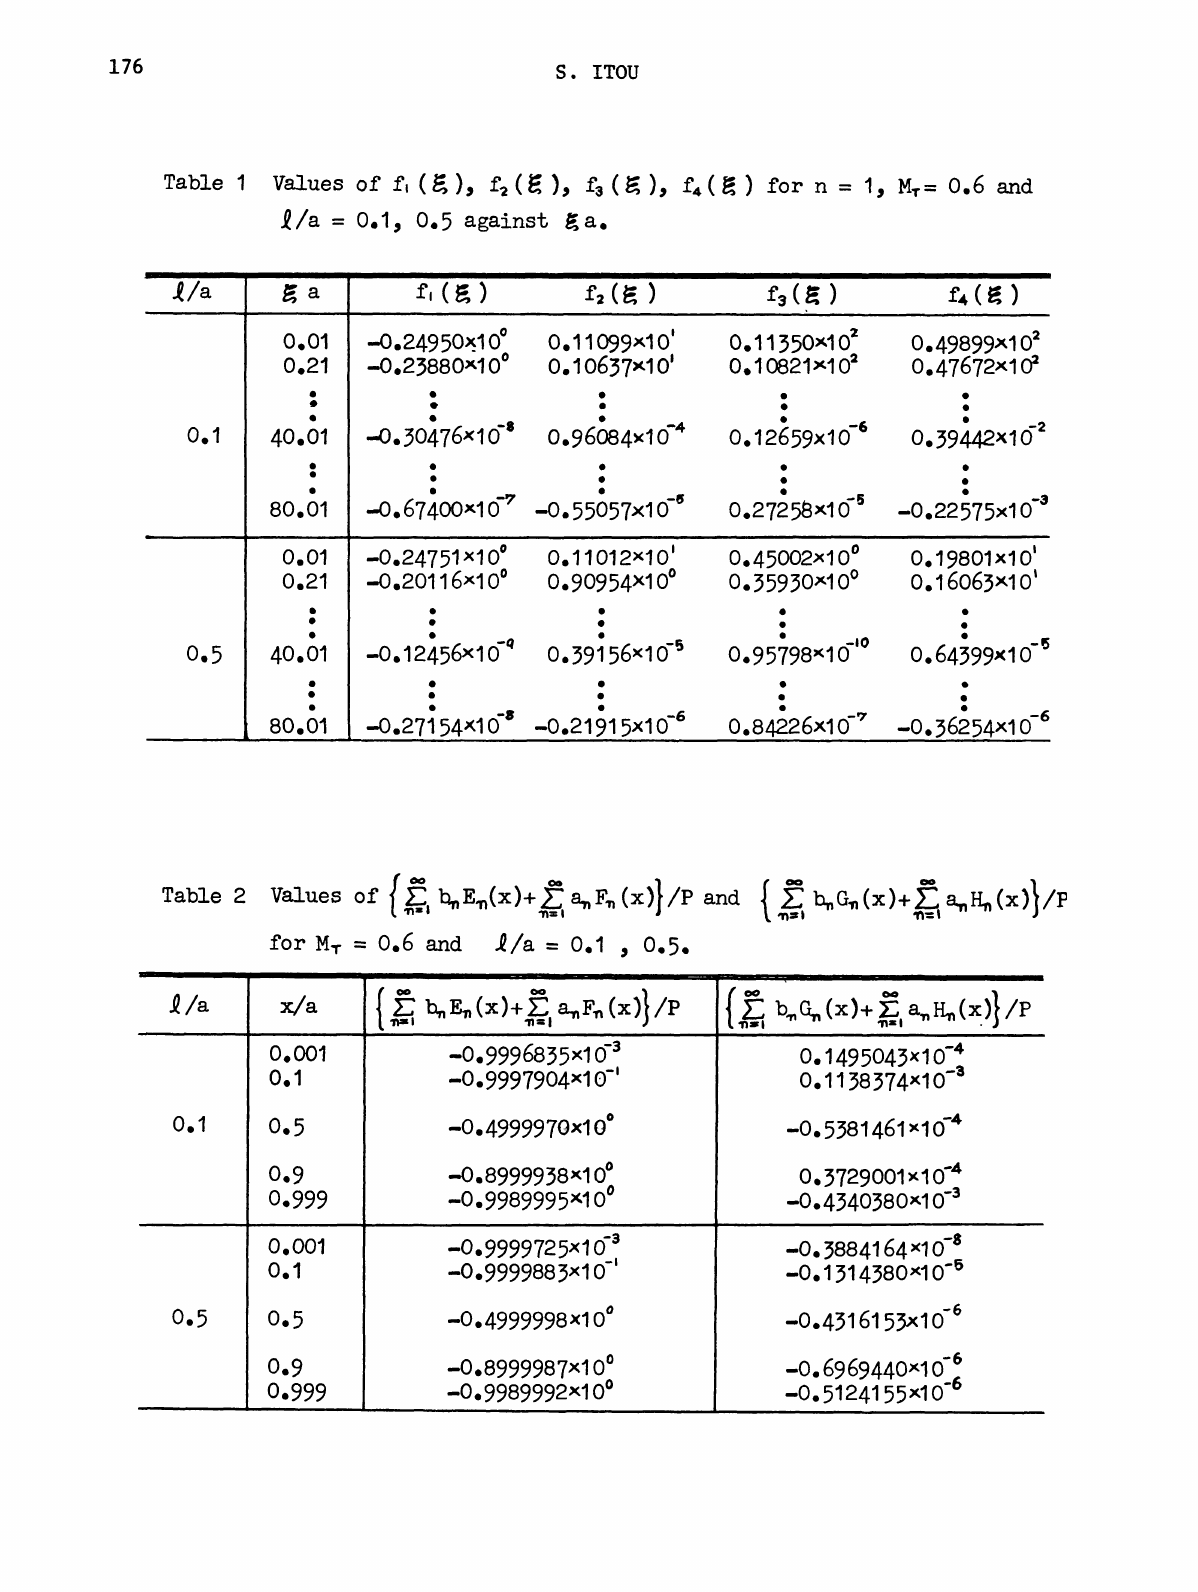
Values of f, (), f2(), fs(), f4() for n